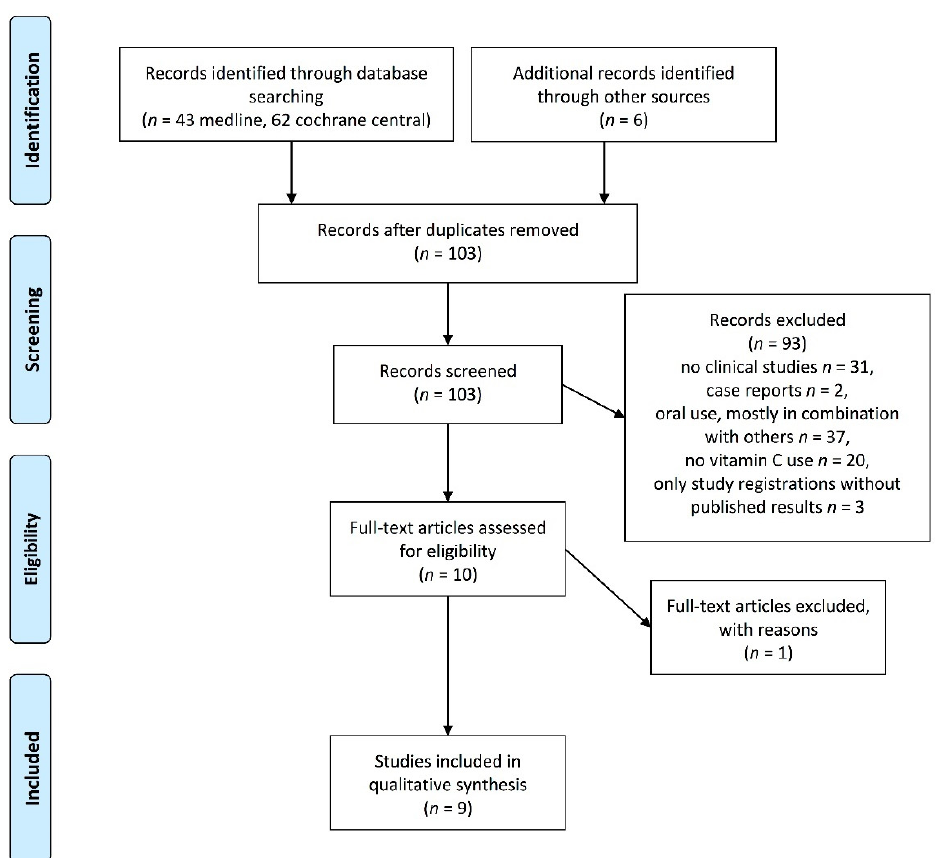
Figure 1. Documentation of study selection for the systematic review according to PRISMA guidelines.